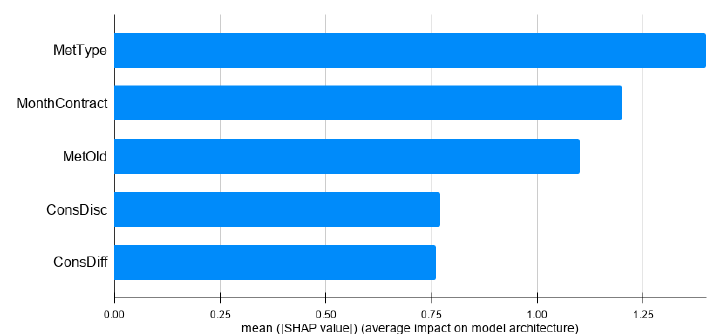
Figure 7. Mean absolute SHAP values for the predictions of Campaign 1 using the Meter Tampering model. The features are MetType (indicates if the meter is smart), MonthContract (the months the customer is in contract), MetOld (antiquity of the meter), ConsDisc (indicates the discrepancy between the consumption curve of the customer vs. average) and ConsDiff (high vs. low customer consumption in a period of